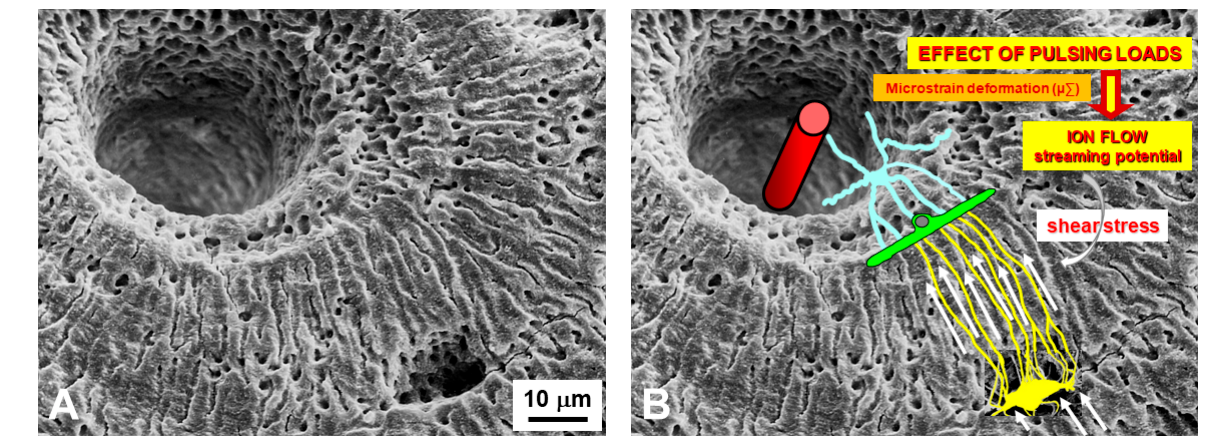
Figure 8. SEM micrograph of a portion of an osteon ( A ) showing the lacuno-canalicular cavities, on which the bone cellular system has been superimposed (in ( B )), to explain the events occurring during mechanical stress: in response to mechanical loading, bone micro-deformations (induced by loading on bone) produce ionic fluxes (streaming potentials) in the bone fluid compartment that, in turn, activate the osteocytes via shear stress. Osteocytes, by means of wiring transmission, issue signals to the cells covering the bone surface, thus activating osteoblast recruitment and bone formation. Vessel (red cylinder inside the Haversian canal); stromal cell (light blue); bone lining cell (green); osteocyte (yellow).